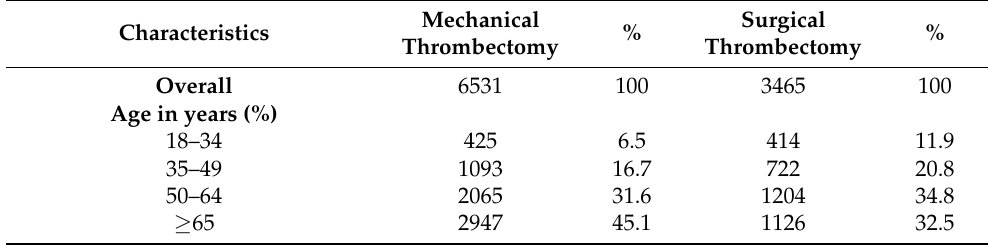
Table 1. Baseline characteristics of inpatient population undergoing mechanical thrombectomy and surgical thrombectomy.